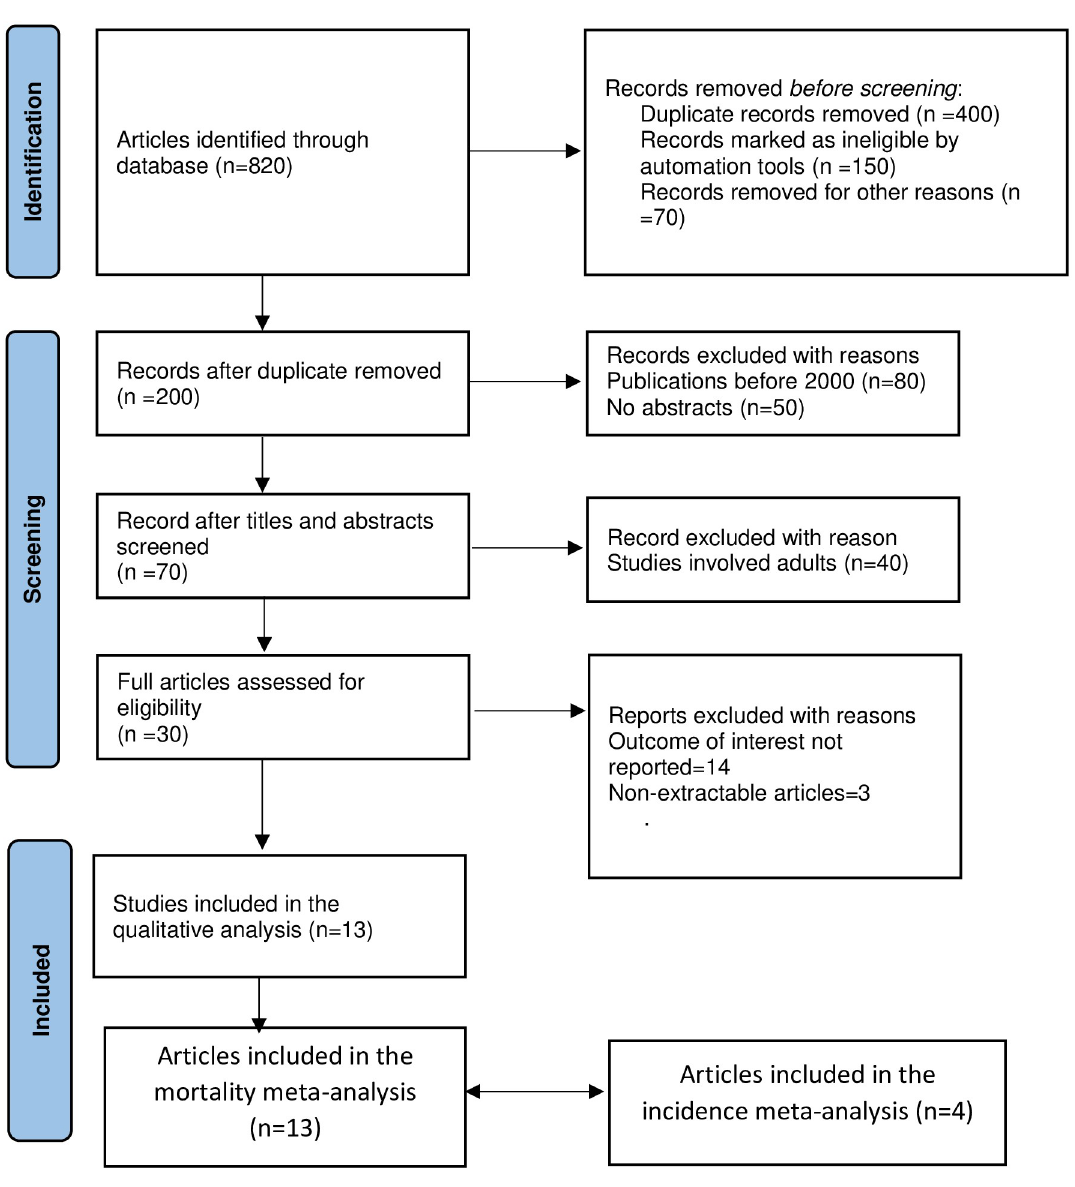
Fig 1. PRISMA flowchart diagram of study selection. compared to studies from 2017 and above 10.0%, [95% CI: 5.0%-14.0%]. Based on the study design, prospective study and retrospective had a pooled case fatality rate of 7.0%, [95% CI: 0.0%-13.0%] and 10.0%, [95% CI: 3.0%-17.0%] respectively (Fig 3). Pooled incidence proportion of children with traumatic brain injury in Sub-Saharan Africa Four studies reported on the incidence of children’s TBI in SSA. The pooled analysis indicated incidence proportion of 18% [95% CI: 2.0%-33.0%]. A substantial heterogeneity (I 2 = 98.9%, P < 0.000) was seen among the studies (Fig 4).